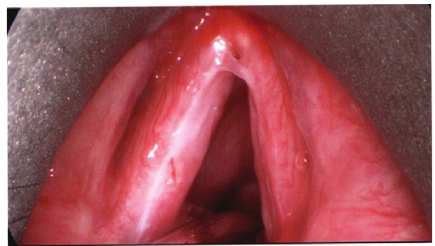
Figure 2: Resolution of invasive